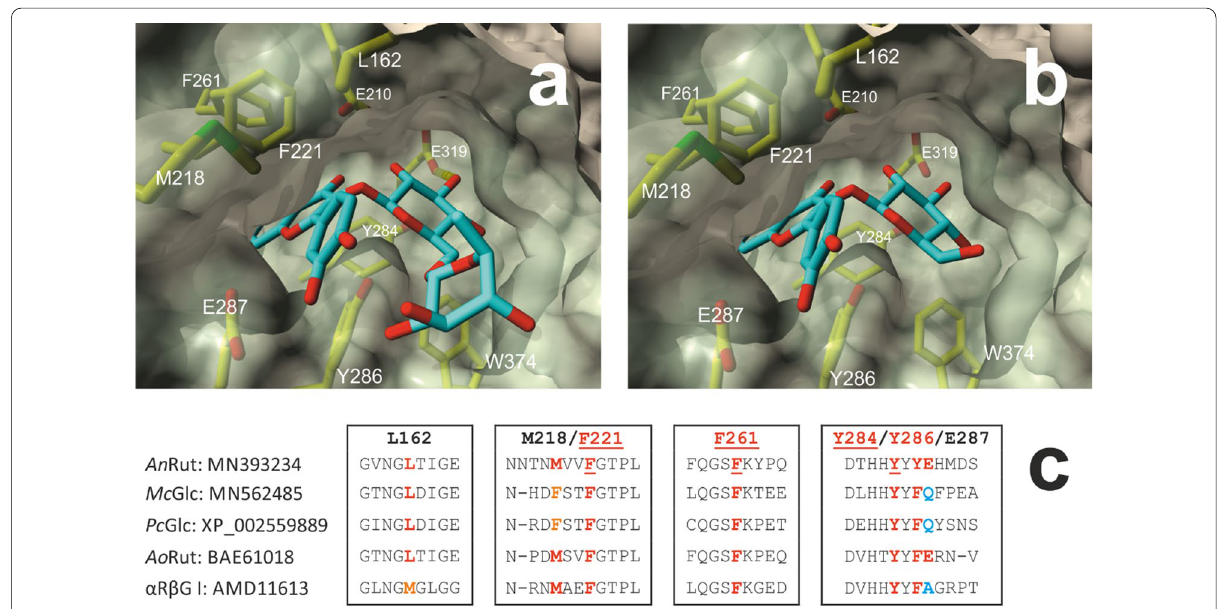
Fig. 2 View of the main entrance to the active site of An Rut with bound substrate 1 or 2 and multiple sequence alignment of GH5-23 member enzymes. a Molecular model of 2 docked to the active site with a free energy of binding of –10.2 kcal mol –1 . b Molecular model of docked 1 with a free energy of binding of –9.3 kcal mol –1 . Residues that interact with the bound substrates are labeled and shown in stick representation. These include in particular the aromatic sidechains of F221, F261, Y284 and Y286, which interact with the aglycones via many hydrophobic and π–π interactions (Additional file 1: Tables S2–S5). In addition, hydrophobic interactions between the aglycones and the sidechains of L162, M218 and E287 were also found. The catalytic nucleophile E319 and the acid/base catalyst E210 are shown as well. The most favorable binding poses of 1 and 2 are shown. The double ring moiety of quercetin (rings A and C; see Fig. 1) is buried in the side tunnel and only incompletely visible. The above-mentioned residues were set flexible during the simulation. The An Rut-based residues are covered with a partially transparent molecular protein surface. c Multiple sequence alignment of GH5-23 member enzymes. Only segments around residues that—according to the molecular docking results—are involved in hydrophobic and π-π interactions between the quercetin moiety of 1 or 2 and the 1 subsite of An Rut are + shown. The aromatic residues F221, F261 and Y284 are fully conserved. The residues at the positions 162, 218 and 286 are partially conserved. The numbering refers to the sequence of An Rut (MN393234) (Pachl et al. 2020). The following sequences were aligned: MN562485 ( Mc Glc)